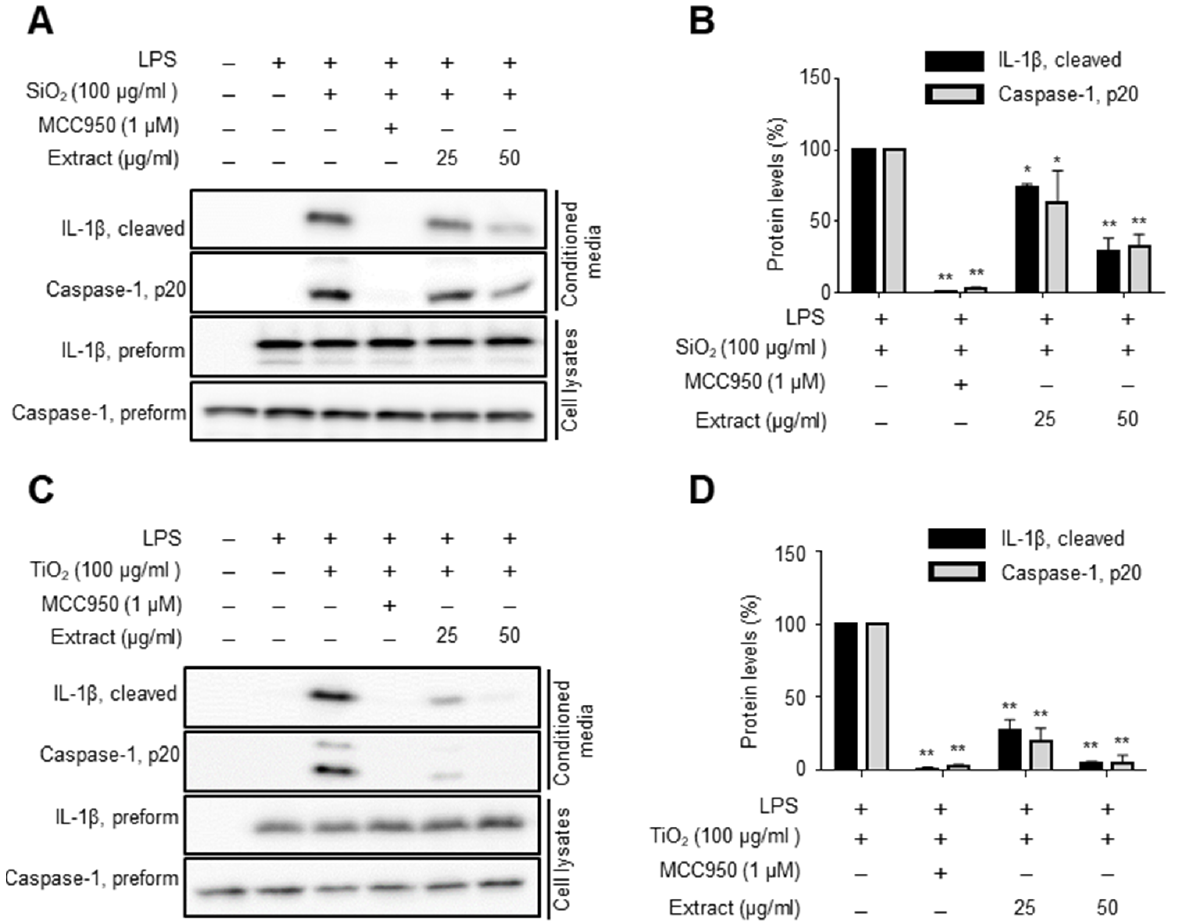
Figure 1. Identification of C. phaeocaulis extract as an inhibitor of NLRP3 inflammasome in vitro. Bone marrow-derived mononuclear cells were differentiated into macrophages. The cells were primed with lipopolysaccharide for 2 h, and then they were pretreated with either DMSO, MCC950, or extract for 1 h before inflammasome activation by either SiO 2 ( A , B ), or TiO 2 ( C , D ) nanoparticles. The conditioned media and total lysates were used for Western blot analysis (left). Data from three independent replicates are shown for cleaved IL-1 β and caspase-1 (p20) as bar graphs. (right). Data are expressed as mean ± standard deviation (SD), and different symbols indicate differences at * p < 0.05, ** p < 0.001 vs. LPS + SiO 2 , or LPS + TiO 2 group.